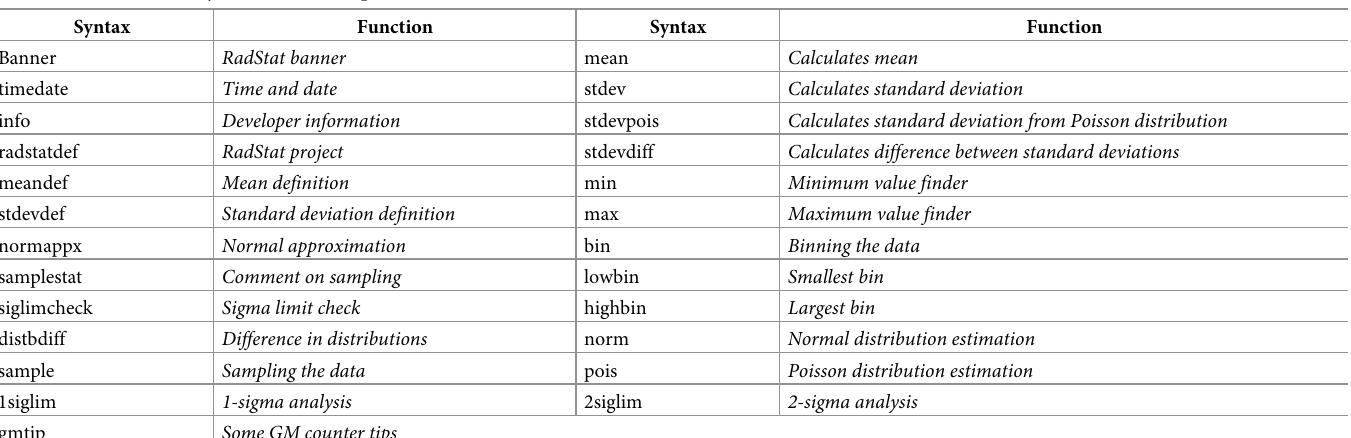
Table 1. List of RadStat syntaxes and their specific